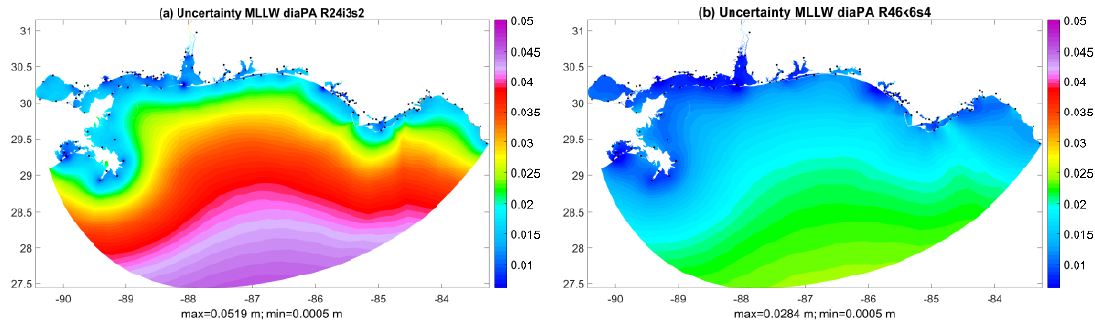
Figure 14. Sensitivity of spatially varying uncertainty to model error. ( a ) Before and ( b ) after error reduction (e.g., Figure 13a vs. Figure 6c). Tests were conducted using 144 tide stations with RMSE data. Unit for the color bar is in meter.